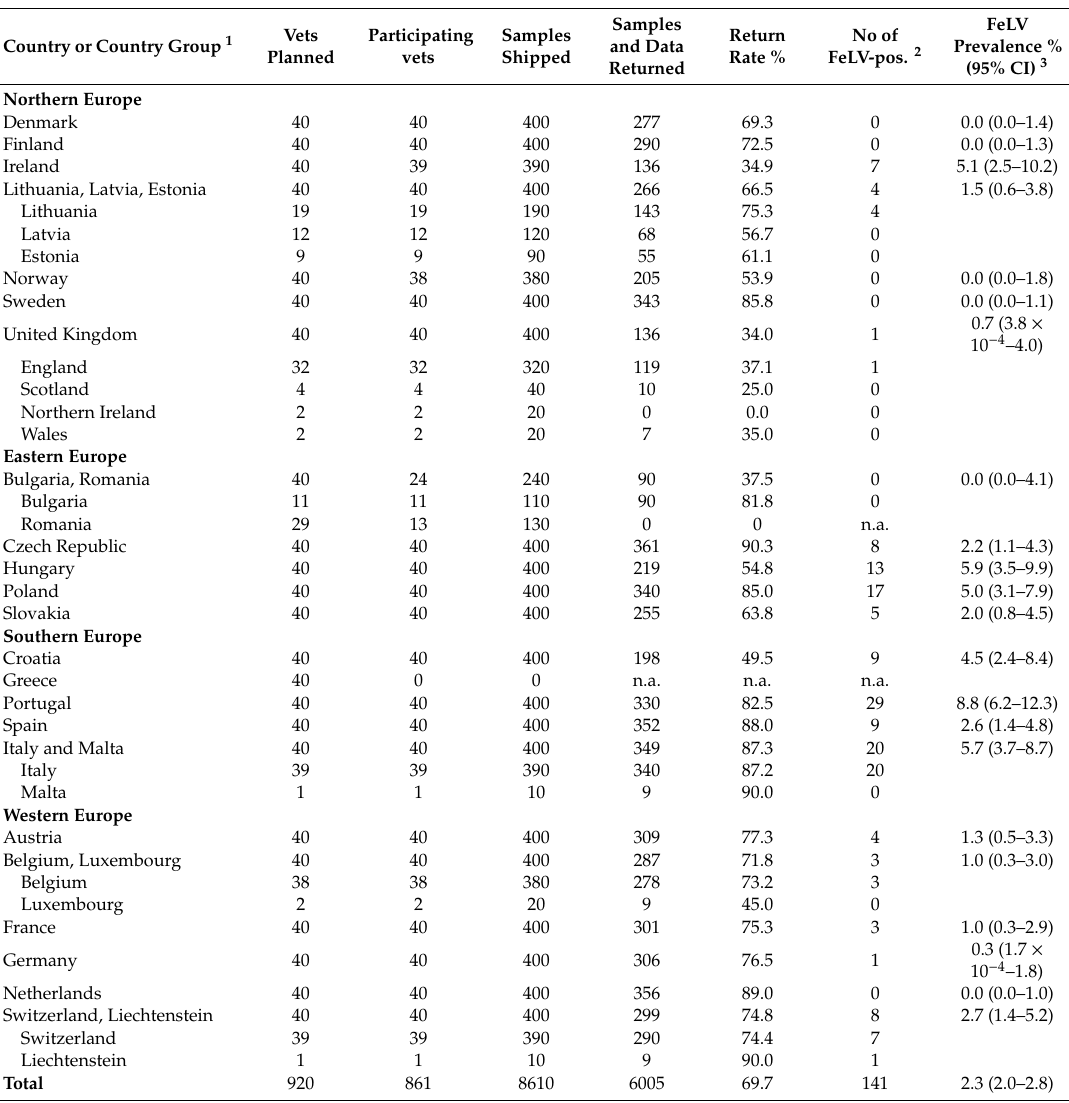
Table 1. Numbers of veterinarians, samples shipped and returned, and feline leukaemia virus (FeLV) prevalence in the di ff erent countries or country